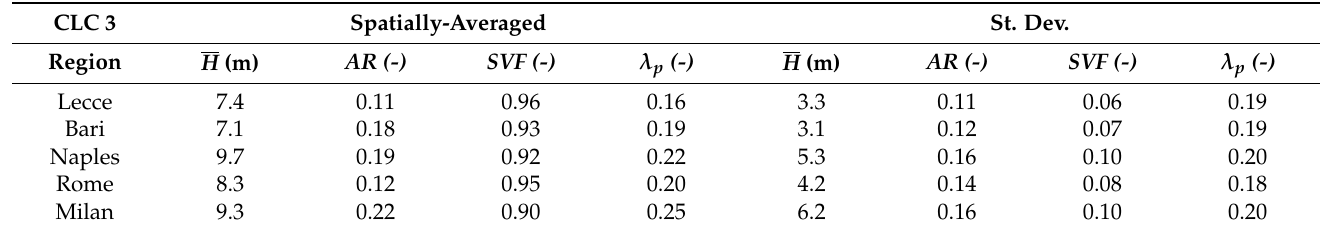
Table 4. Spatially-averaged values and standard deviations of the morphological parameters over the CLC 3